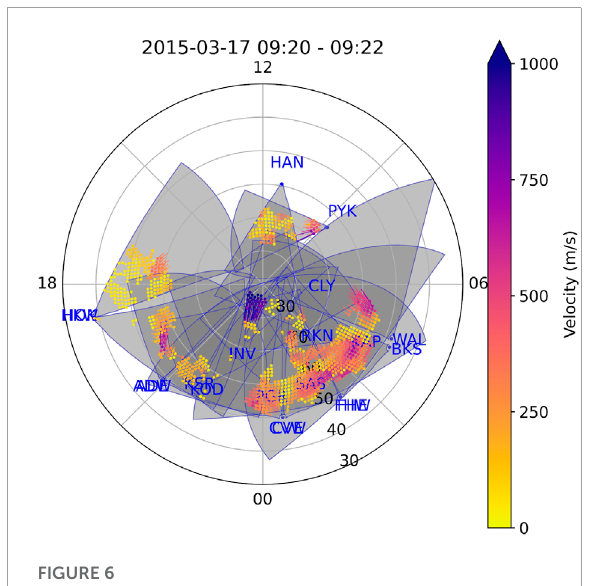
FIGURE 6 Gridded velocity map derived from multiple northern hemisphere radars at 09:20–09:22 UT on 17 March 2015.